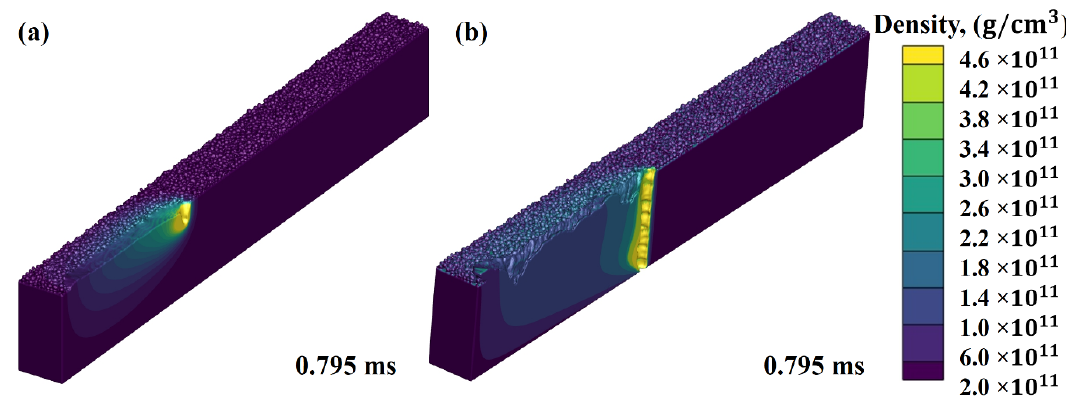
Figure 8. Transformation from shallow depth melt flow to deep keyhole formation when laser power increased from ( a ) 170 W to ( b ) 200 W.